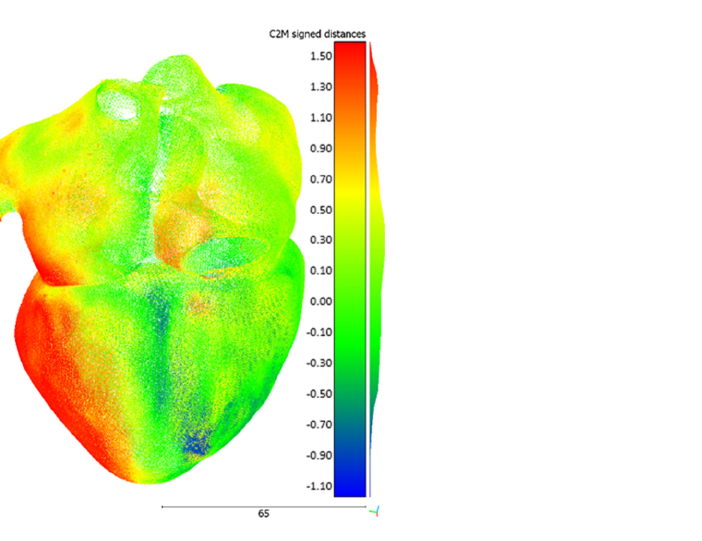
Figure 8. Hollow heart model comparison result in CloudCompare. Values are in millimeters.